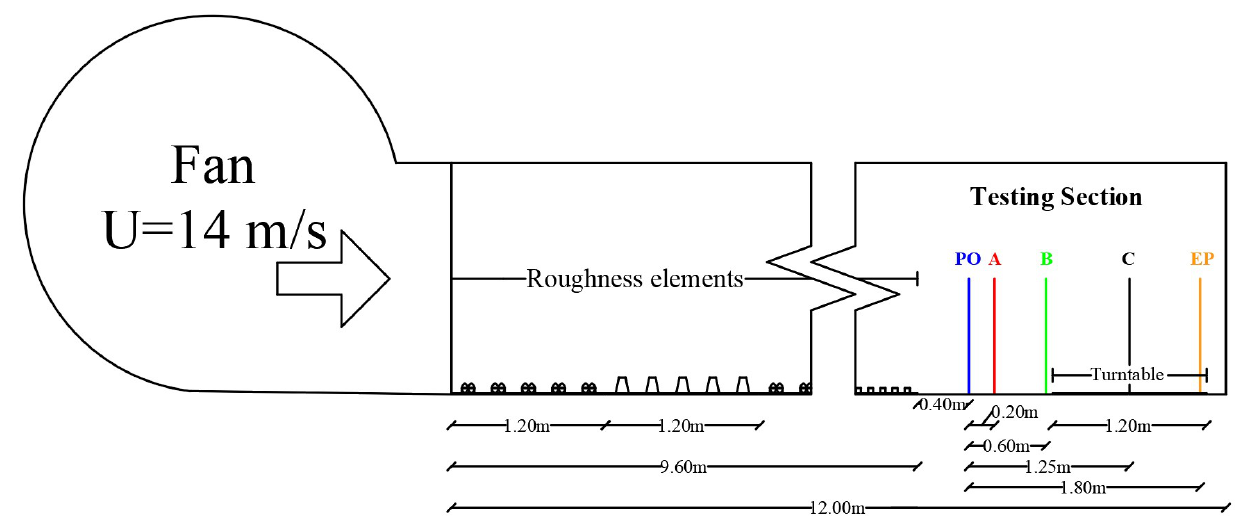
Figure 1. Wind Tunnel of Concordia University—schematic